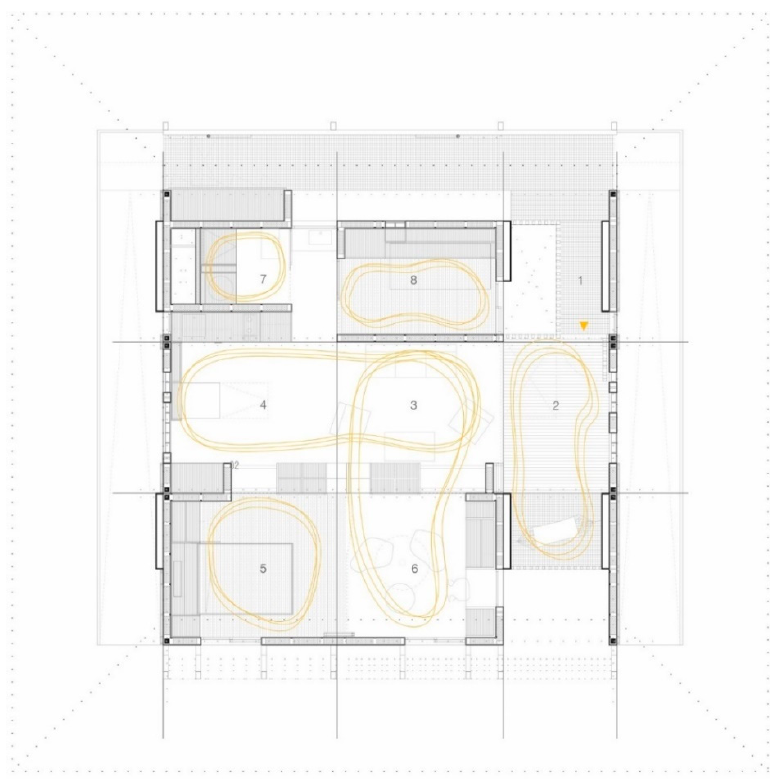
Figure 9. Scheme adaptable spaces that make housing: 1.Access, 2.Hallway, 3.Living room, 4.Kitchen, 5.Use nº1, 6.Use nº2, 7.Bathroom, 8.Use nº3.